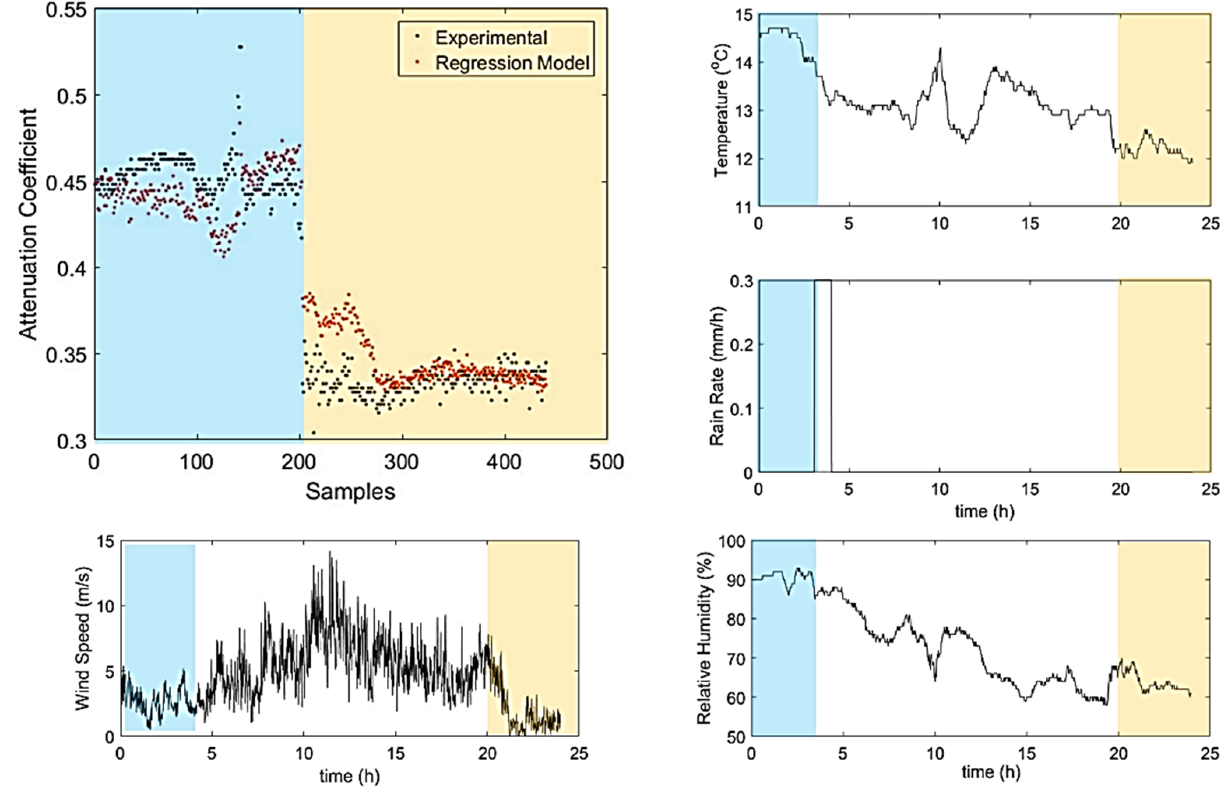
Figure 7. Experimental measurements and model predictions, i.e., Equation (6), for 15 February 2020.